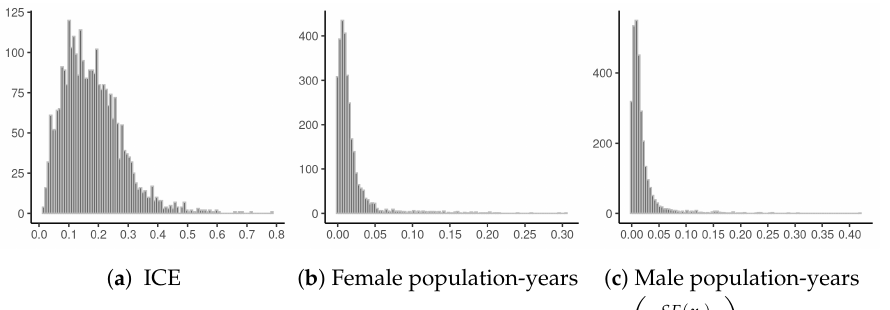
Figure 8. Data quality for county ACS variables. Scaled SEs estimates, and CVs are shown for population at risk